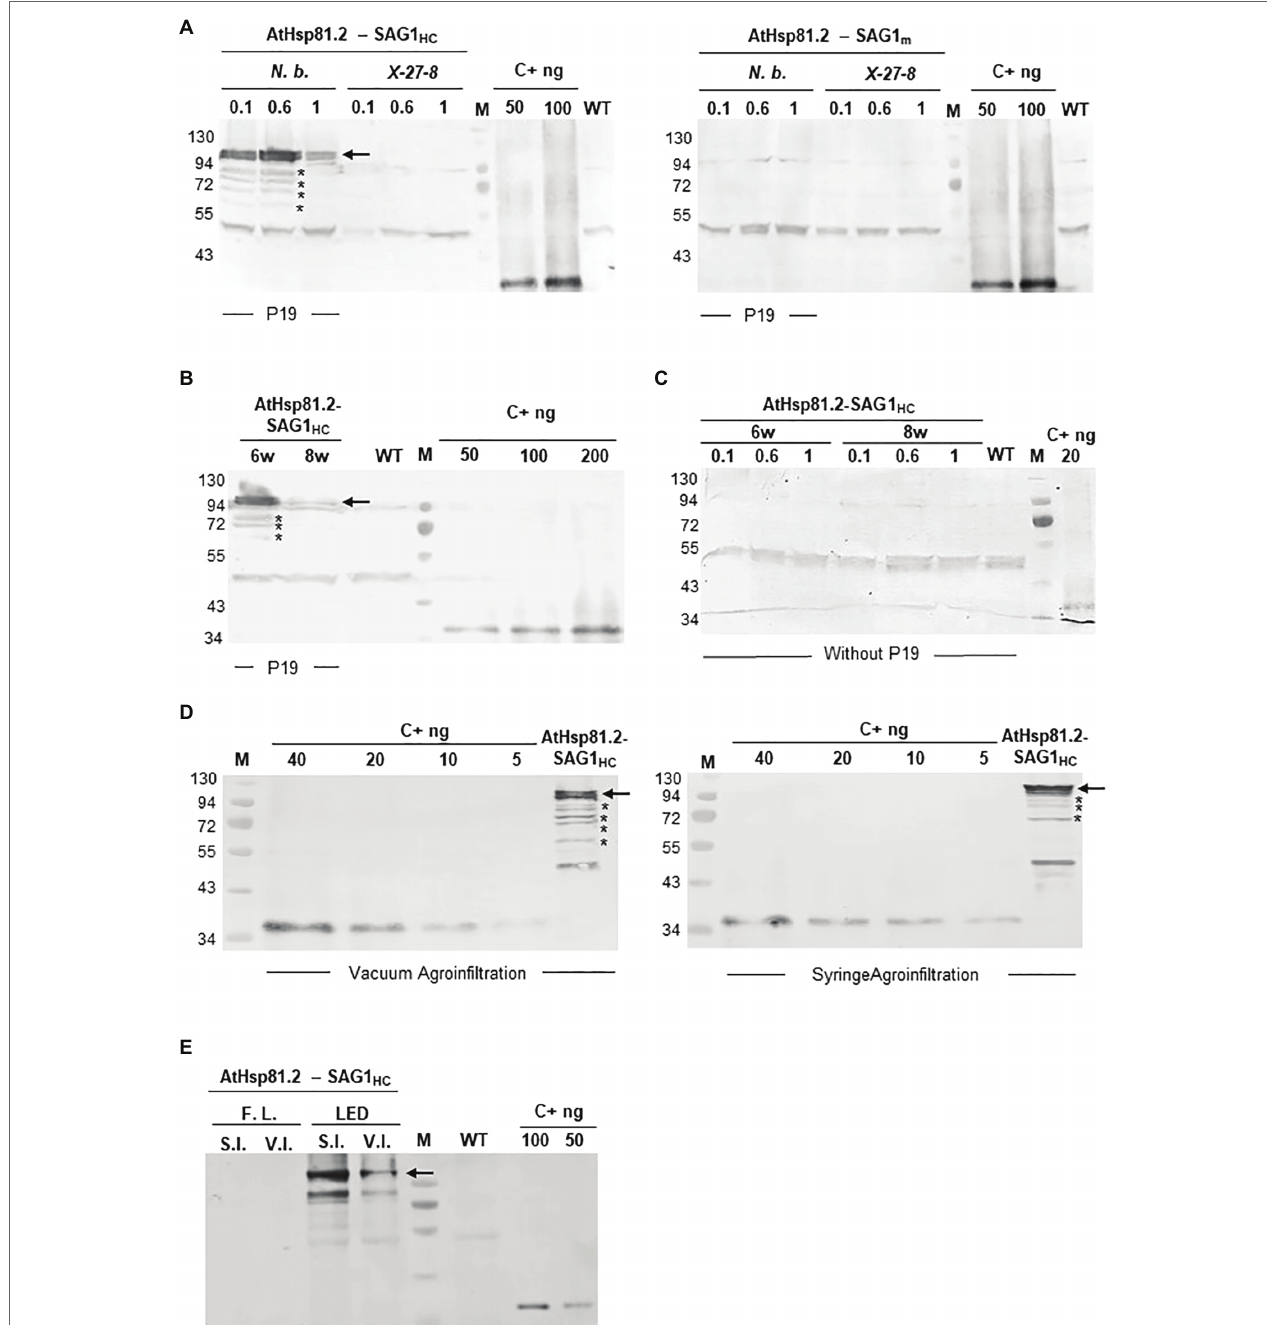
FIGURE 2 | Expression and quantification of AtHsp81.2–SAG1 HC and AtHsp81.2–SAG1 m produced in Nicotiana benthamiana using Western blot analysis. (A) Fresh material from N. benthamiana leaves or the X-27-8 transgenic line of N. tabacum leaves harvested 7 days after syringe infiltration using A. tumefaciens [optical density (OD) 600nm = 0.1, 0.6 and 1.0]. Nicotiana benthamiana leaves were co-agroinfiltrated with the p19 suppressor and AtHsp81.2–SAG1 HC or AtHsp81.2–SAG1 m constructs, whereas transgenic line X-27-8 leaves were agroinfiltrated with AtHsp81.2–SAG1 HC or AtHsp81.2–SAG1 m constructs alone. (B) Fresh material from N. benthamiana leaves of 6- and 8-week-old plants, harvested 7 days after syringe infiltration with A. tumefaciens (OD 600nm = 0.6). N. benthamiana leaves were co-agroinfiltrated with the p19 suppressor and AtHsp81.2–SAG1 HC . (C) Fresh material from N. benthamiana leaves of 6- and 8-week-old plants, harvested 7 days after syringe infiltration with A. tumefaciens (OD 600nm = 0.1, 0.6, and 1.0). N. benthamiana leaves were co-agroinfiltrated with AtHsp81.2–SAG1 HC without the p19 suppressor. (D) Fresh material from N. benthamiana leaves of 6-week-old plants, harvested 7 days after syringe or vacuum agroinfiltration with A. tumefaciens (OD 600nm = 0.6). Nicotiana benthamiana leaves were co-agroinfiltrated with the p19 suppressor and AtHsp81.2–SAG1 HC . (E) Fresh material from N. benthamiana leaves of 6-week-old plants and harvested 7 days after syringe or vacuum infiltration with A. tumefaciens (OD 600nm = 0.6). N. benthamiana leaves were co-agroinfiltrated with the p19